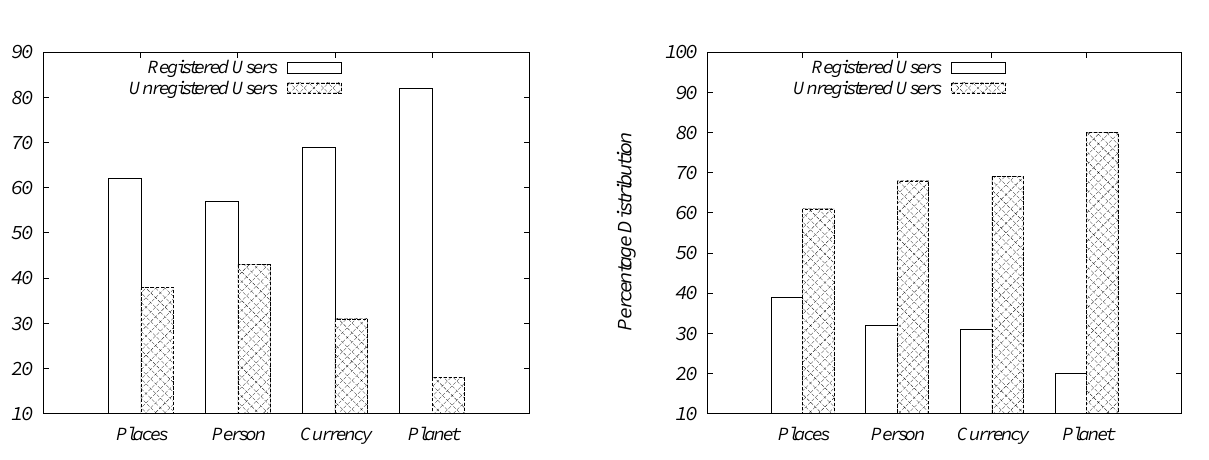
Figure 5. Registered and Unregistered Contributions for Legitimate Edits